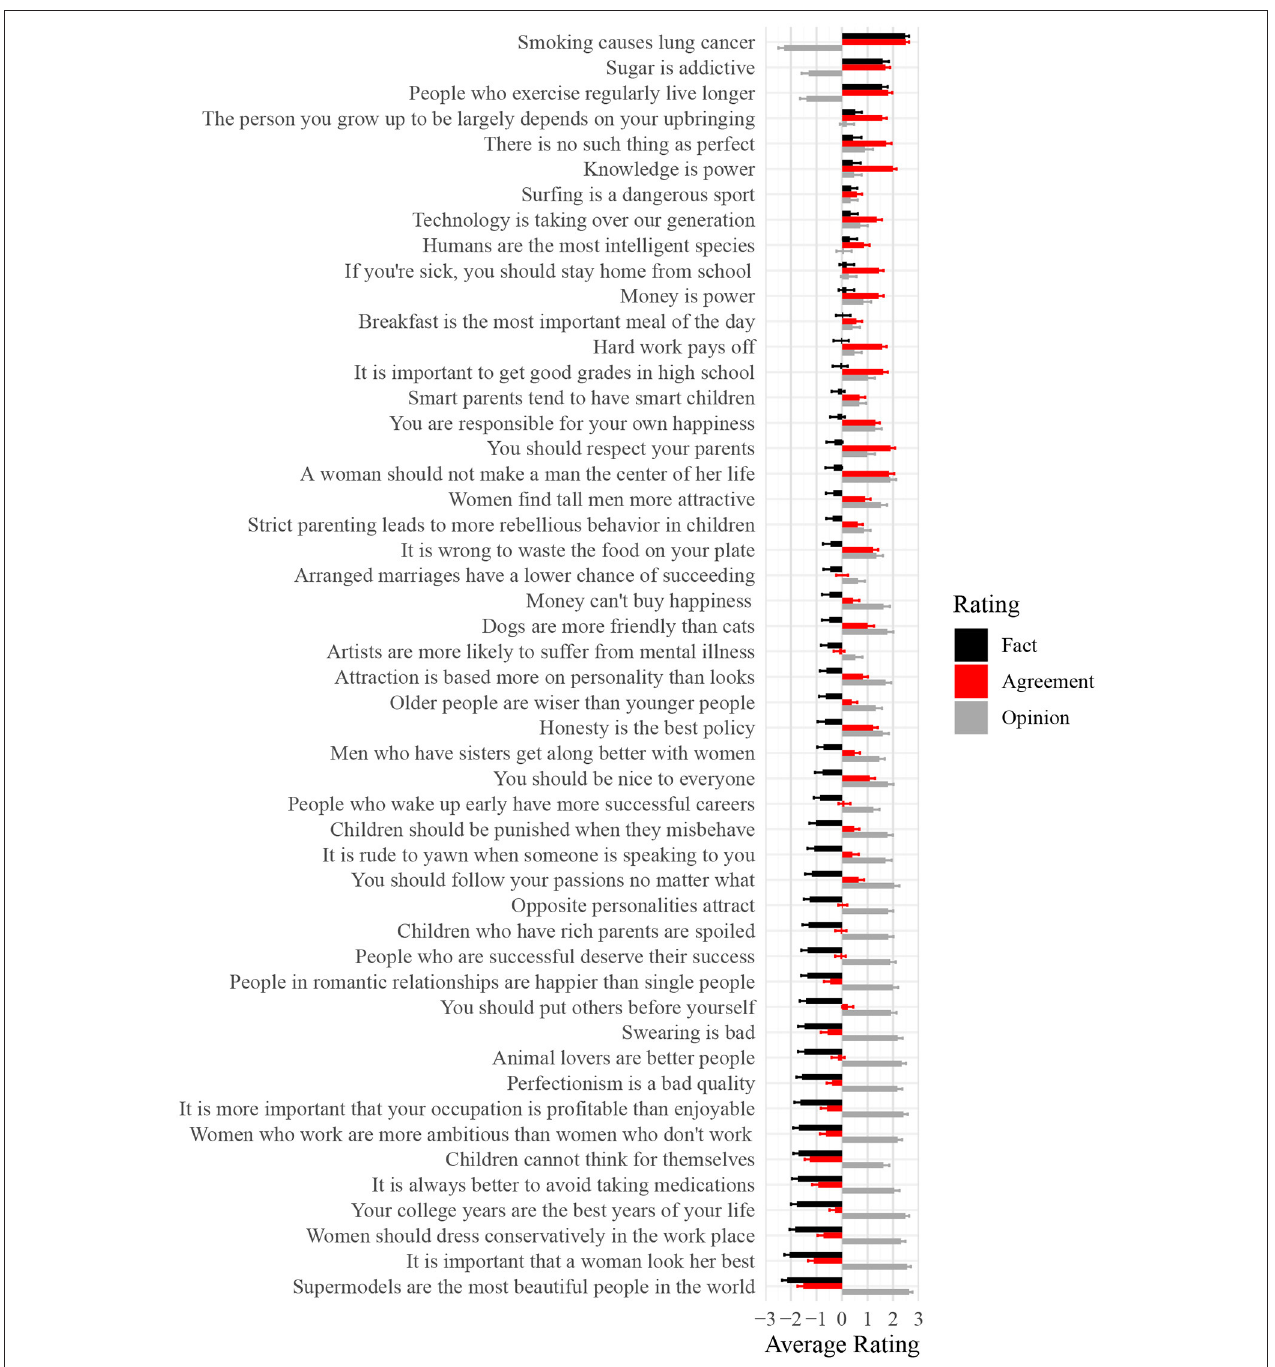
FIGURE 1 | Average fact, opinion, and agreement ratings for each of the fifty statements used in Study 1. Scores of − 3 and +3, respectively correspond to the labels “This is not a fact” and “This is a fact” for Fact ratings; “This is not an opinion” and “This is an opinion” for Opinion ratings; and “I completely disagree” and “I completed agree” for Agreement